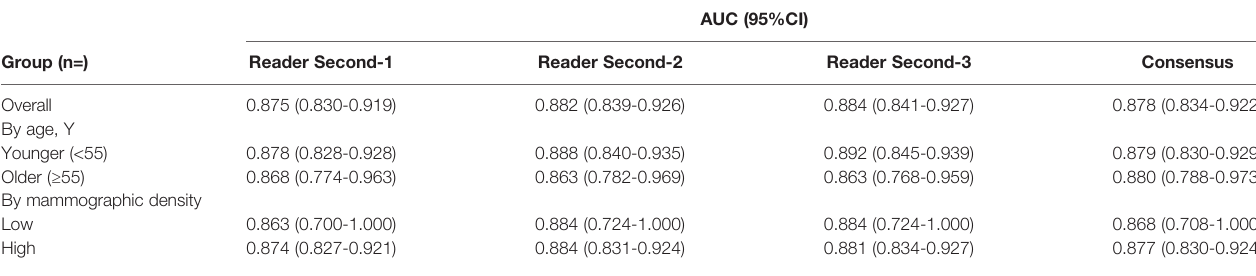
TABLE 3 | Area under the receiver operating characteristic curves for the 3 second and consensus readers.